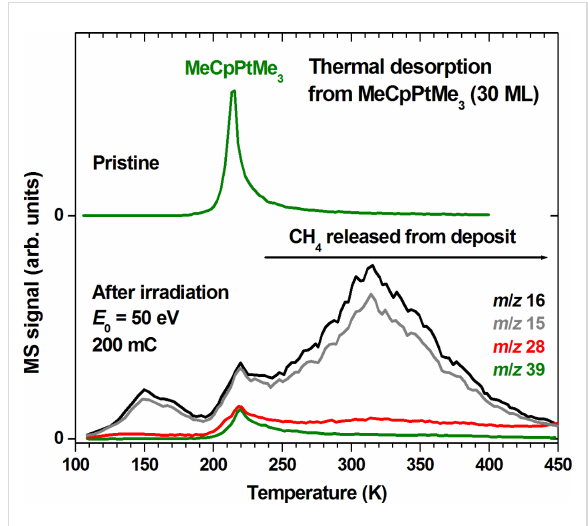
Figure 4: Thermal desorption spectra recorded from a 30 layer film of MeCpPtMe 3 as deposited at 105 K on a Ta substrate (top) and from the MeCpPtMe 3 film prepared for the experiment shown in Figure 3 but after a total electron exposure of 40 mC/cm 2 at E 0 = 50 eV (bottom). The m / z ratios 16, and 15 were recorded to monitor the possible for- mation of CH 4 for which their relative intensities amount to 1:0.9 [10]. The m / z ratio 28 is included to monitor possible release of C 2 H 6 and m / z 39 (C 3 H 3+ ) is included as a characteristic MS signal of MeCpPtMe 3 (see [11]). Only m / z 39 is shown for clarity in the case of the fresh layer (top) where other desorption signals were absent (see Supporting Information File 1, Figure